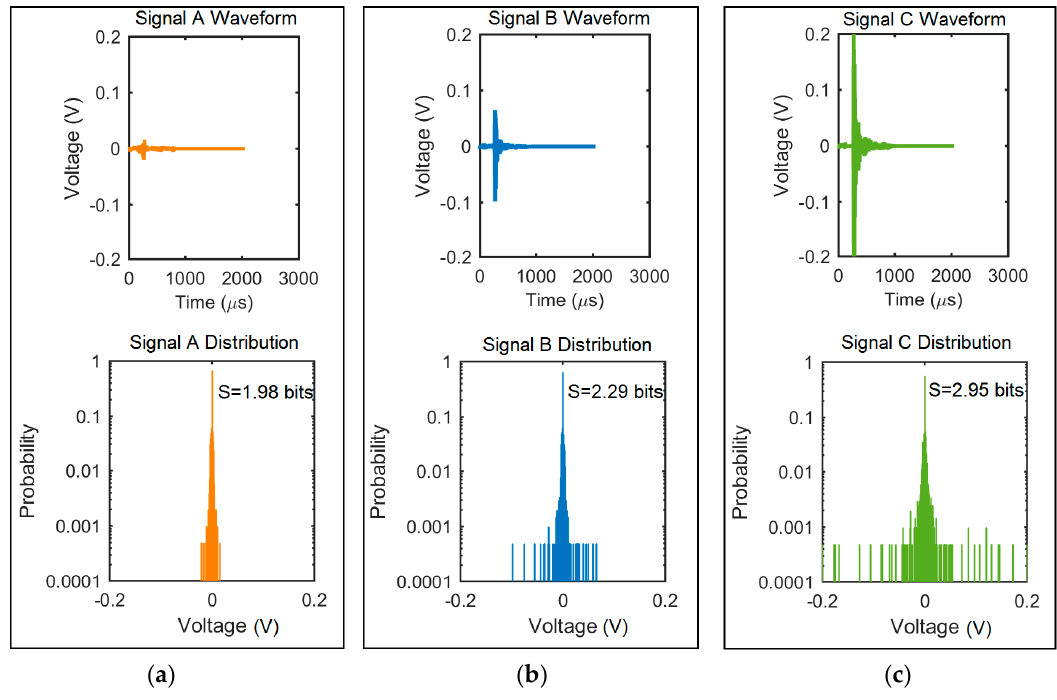
Figure 2. Waveforms, voltage distributions, and information entropy values for three AE (acoustic emission) signals: ( a ) Signal A captured during relatively little microstructural change; ( b ) Signal B captured during a moderate microstructural change; and ( c ) Signal C captured during a relatively significant microstructural change.